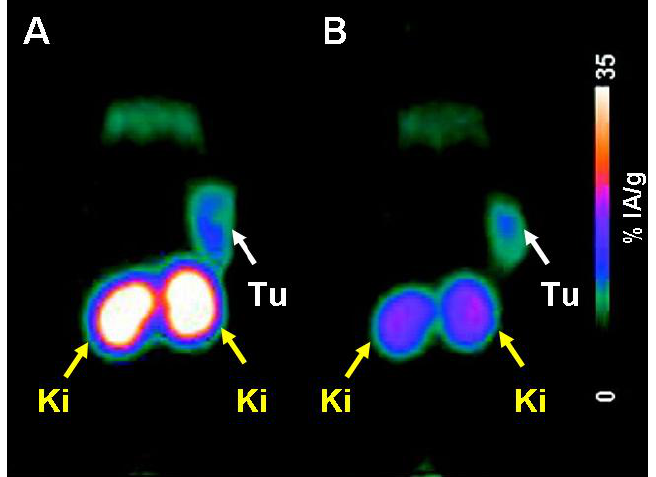
Figure 11. MIP PET images of 68 Ga-P3246 1 h p.i. without ( A ) and with pre-injection of pemetrexed ( B ). (Tu = KB tumor xenograft, Ki = kidney) [51]. Reprinted (adapted) with permission from Fani et al . [51]. Copyright (2012) American Chemical